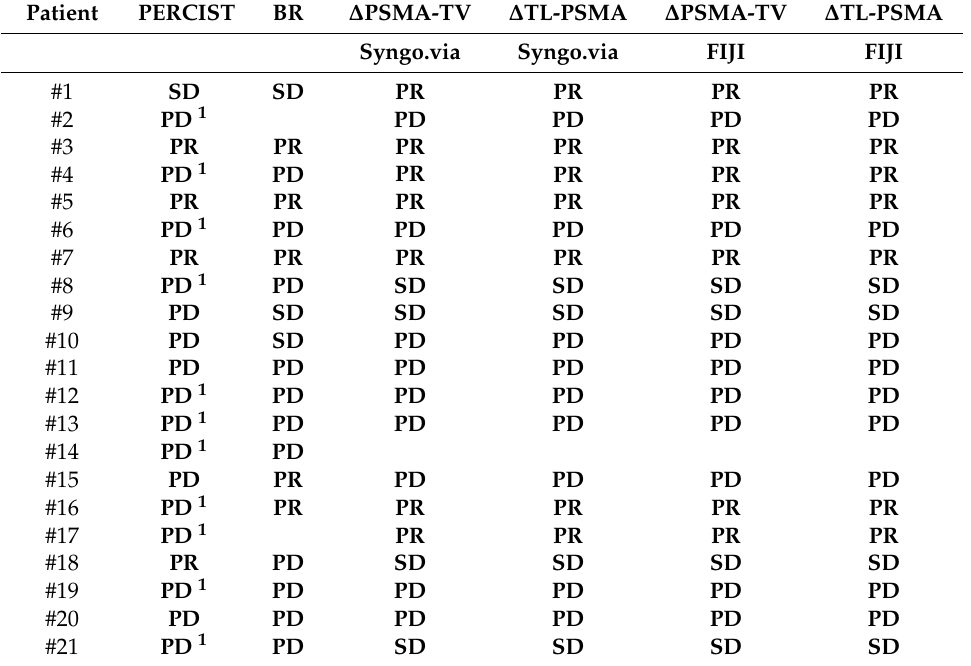
Table 4. Clinical response in terms of PERCIST criteria, biochemical response (BR), ∆ PSMA-TV and ∆ TL-PSMA for castration-resistant prostate cancer (CRPC) patients calculated with the Syngo.via and the FIJI software. Patients with 1 were rated PD in PERCIST due to new lesions. For patient #14, changes in PSMA-TV and TL-PSMA were not calculated due to tracer extravasation at baseline PET / CT—classification according to PERCIST was applicable due to a new lesion at follow-up. PR: partial response; SD: stable disease; PD: progressive